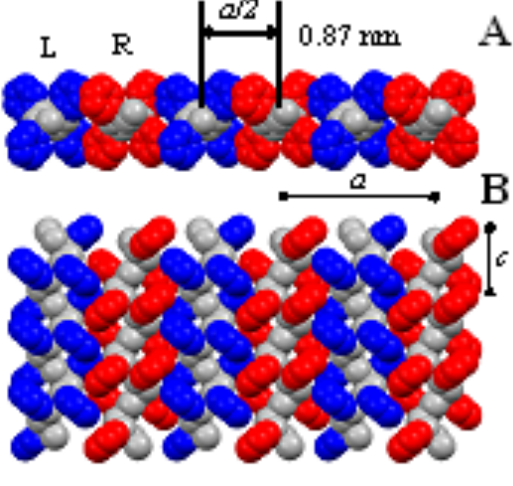
Figure 3. Top (A) and lateral views (B) of the ac layer of s(2/1)2 helices of s-PS, i.e. , the high density and low-energy structural feature which is common to the δ nanoporous form and to the corresponding co-crystalline forms. The minimum interchain distance (0.87 nm) is achieved by alternating enantiomorphous helices (R and L stand for right-handed and left-handed,